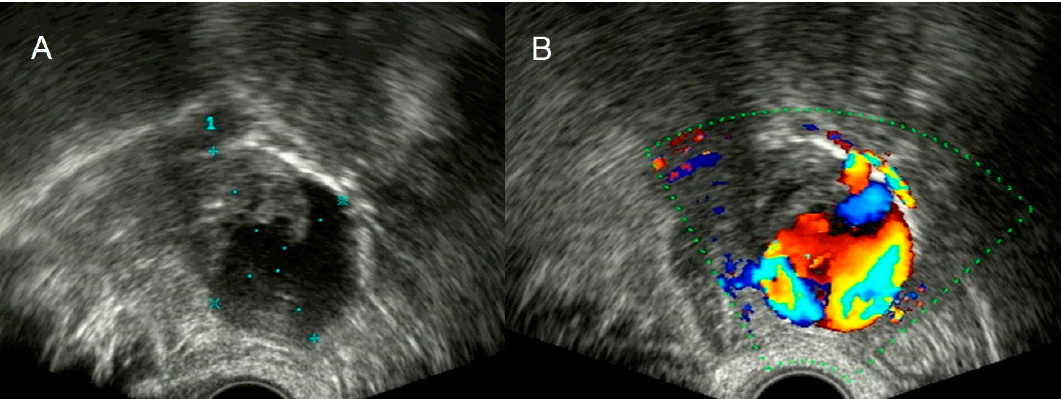
Figure 21. Grayscale transvaginal ultrasound shows a pelvic rounded cystic mass ( A ). Color Doppler evidence vascularization demonstrates the vascular nature of the lesion corresponding to a pelvic aneurysm ( B ).